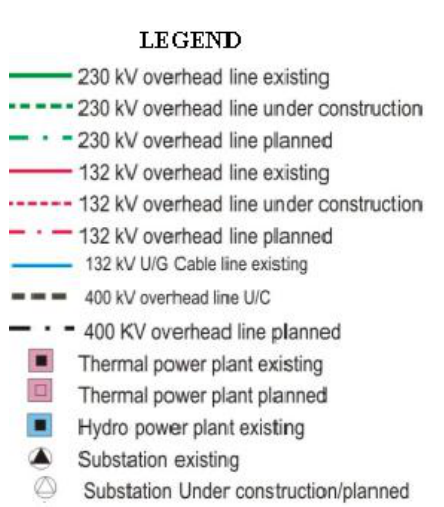
Figure 2. Grid map from Sylhet to